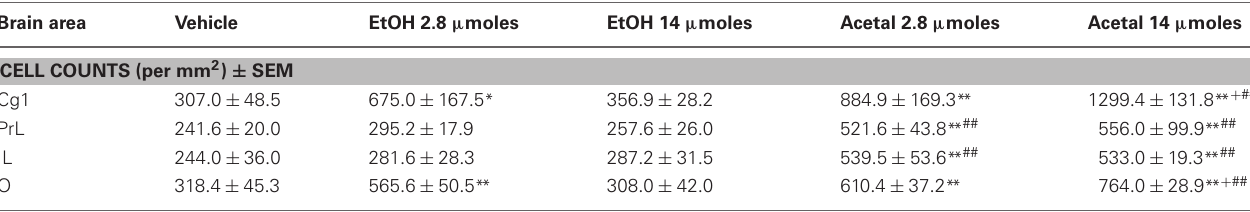
Table 4 | Effect of acute ICV administration of EtOH or acetaldehyde on c-Fos expression in PFC areas of rat brain. Brain area